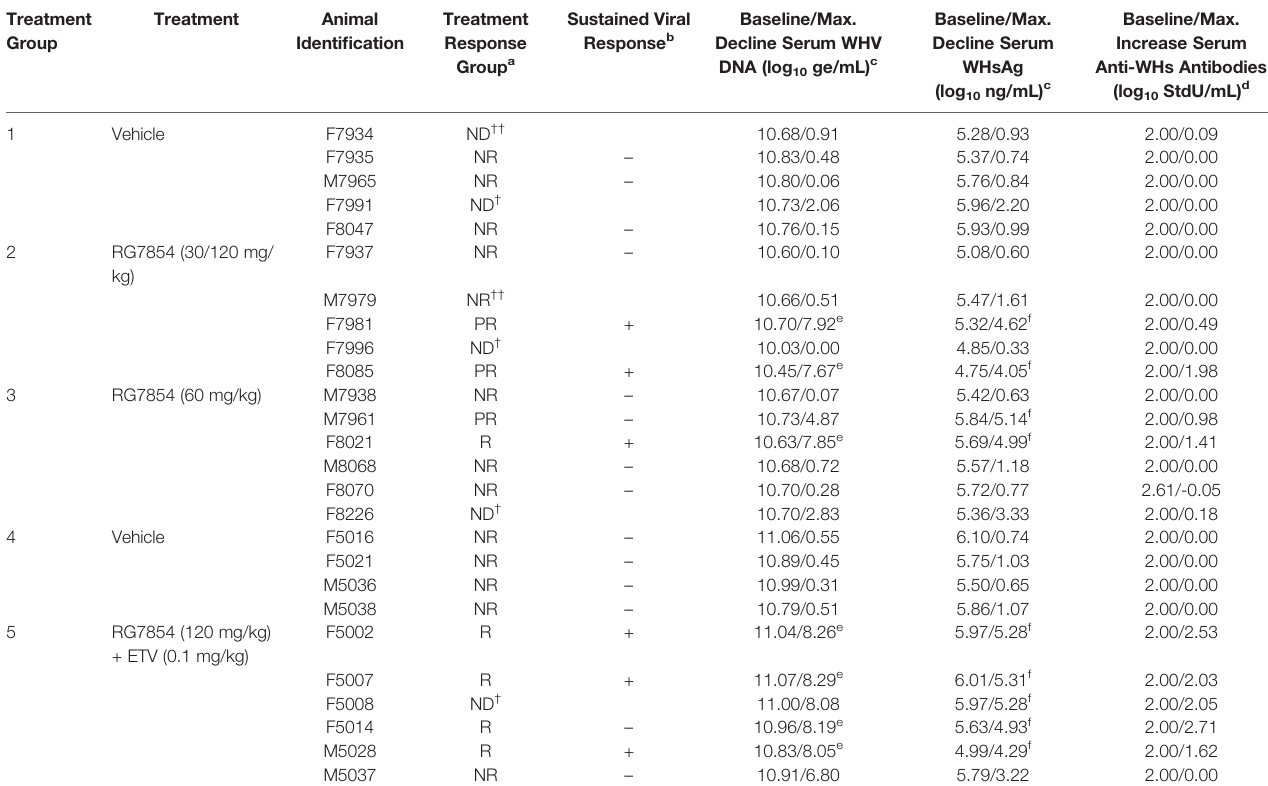
TABLE 1 | Correlative analyses of RG7854 mono and RG7854/ETV combination treatment responses. Treatment